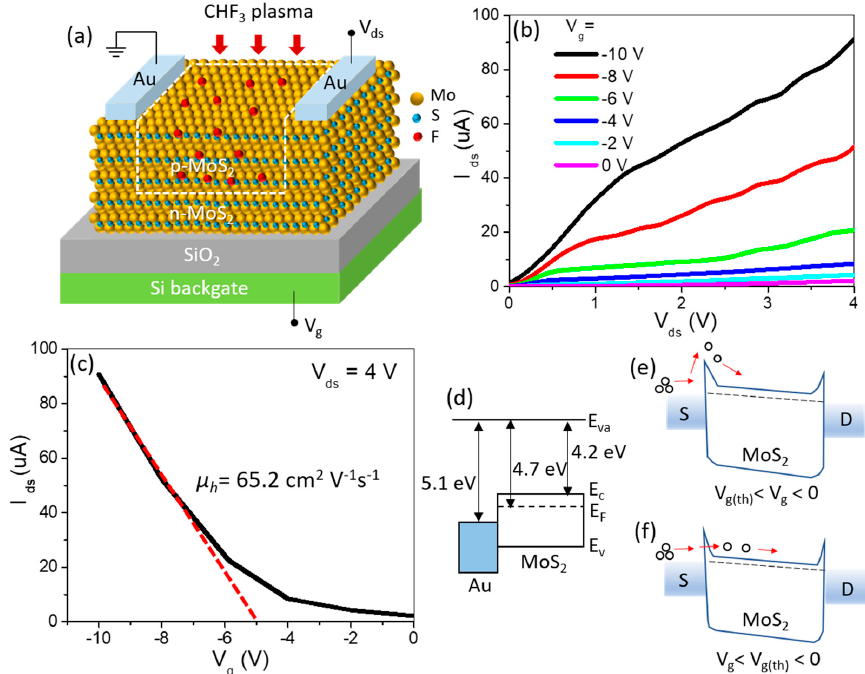
Figure 4. ( a ) Schematic diagram of the back-gated field-effect transistor (FET). Source and drain metal contacts are deposited on the untreated MoS 2 region. F atoms are incorporated into the upper regions of the multilayer MoS 2 . ( b ) I ds –V ds graph of the FET device at different gate bias values ranging from 0 to − 10 V. ( c ) I ds –V g graph displaying transfer characteristic of the MoS 2 p- type FET for V ds = 4 V. ( d – f ) Band diagram of Au/MoS 2 (d) under equilibrium condition, (e) with V g(th) < V g < 0, and (f) with V g < V g(th) < 0.